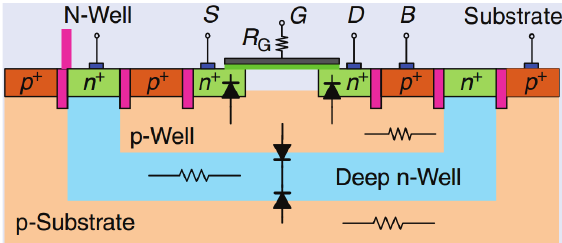
Figure 3 - Triple well NMOS transistor structure. (See the colors in the online